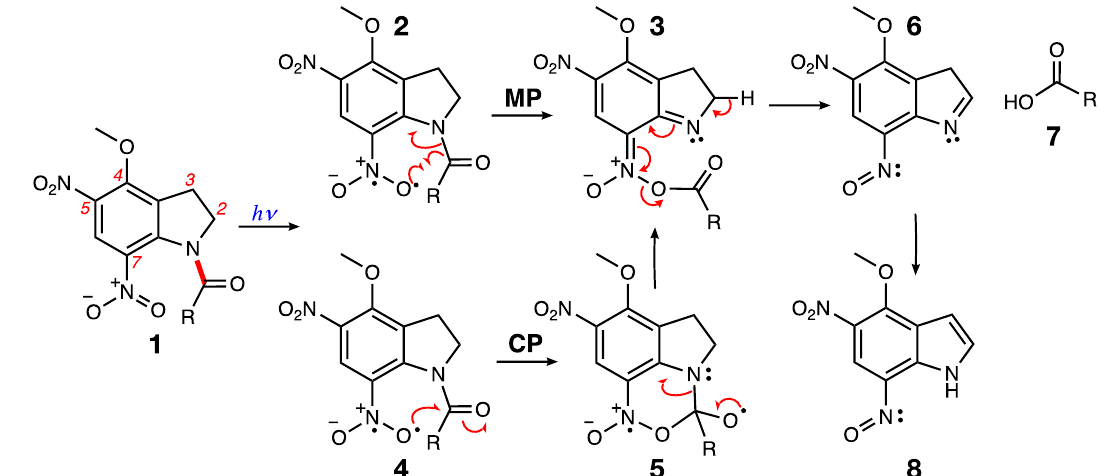
Figure 1. Different proposed mechanisms for the uncaging of MDNI-Glu (R=CH 2 CH 2 CH(NH 2 )COOH): Migration Pathway (MP)—computational mechanism reported by Pálfi et al. 39 ; Cyclization Pathway (CP)— mechanism presumed by Ellis-Davies et al. 34 , based on Morrison’s experimental data 40